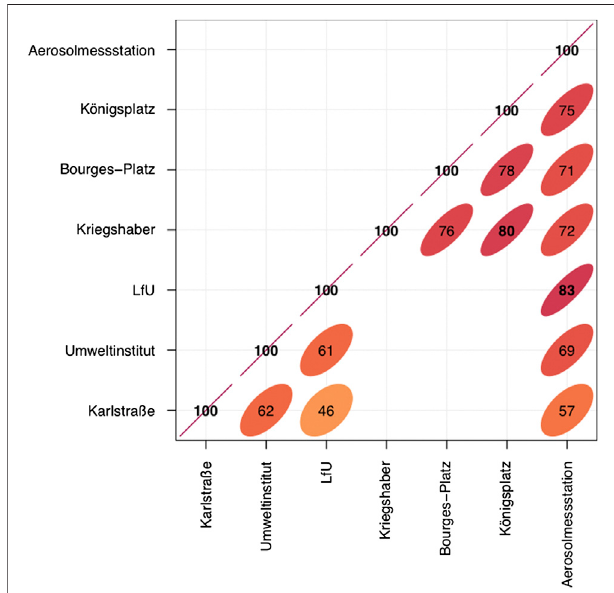
FIGURE 7 | Spearman rank correlation coef fi cients between the hourly UFP number concentrations of all measurement sites [for a better overview only the decimal values after 0. are